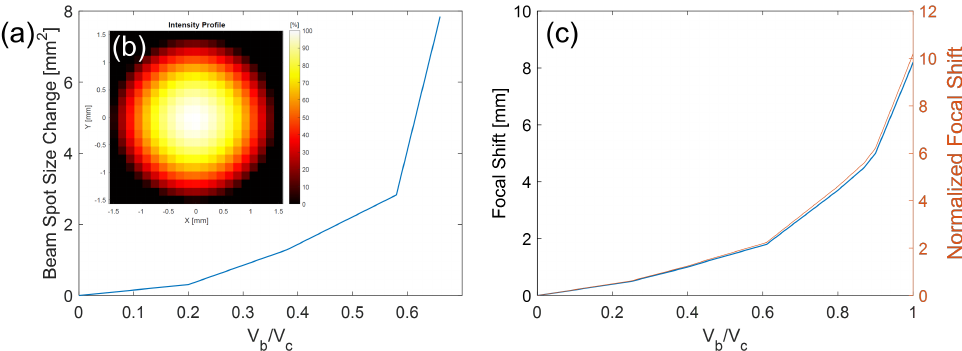
Figure 13. ( a ) Measurements in the beam spot size as a function of bias voltage V b normalized by pull-in voltage V c . ( b ) (Inset) Beam intensity profile with the SWF sensor for membrane at 0.7 of the pull-in voltage, associated with a 100 nm deflection. The pixelation of the figure is due to the lens array of the SWF sensor. ( c ) Measured focal point shifts and normalized focal point shifts relative to the Rayleigh range of the refocused beam as a function of the normalized bias